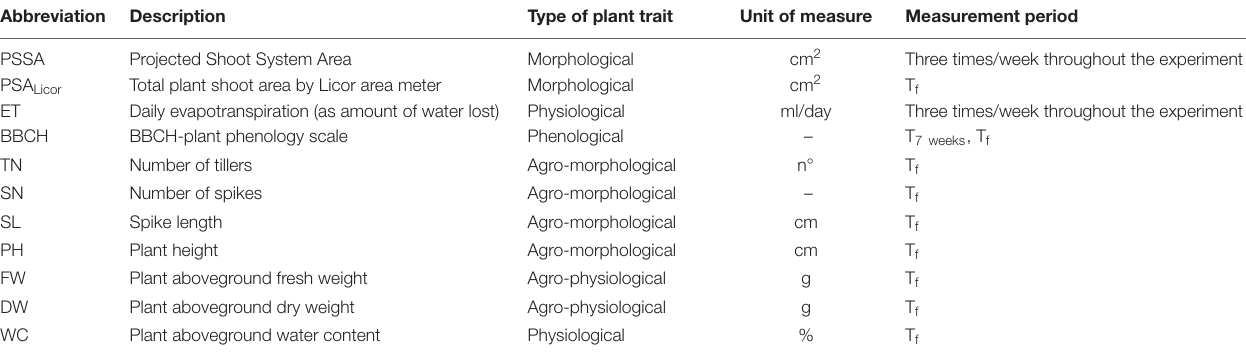
TABLE 3 | List of plant phenotypic traits